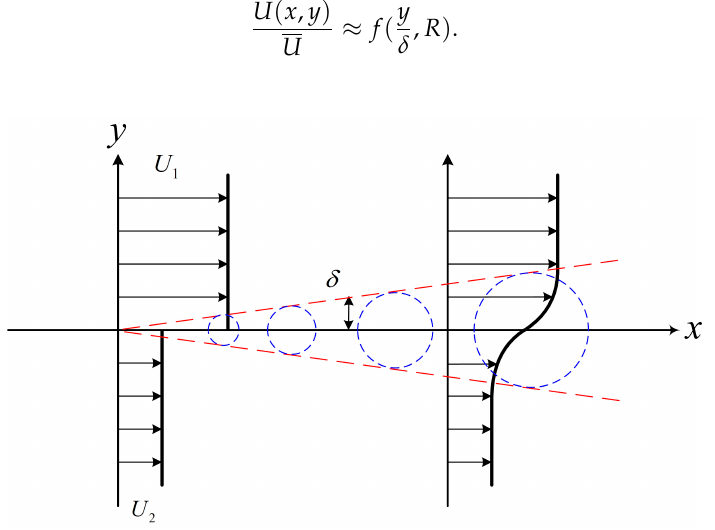
Figure 6. Schematic representation of free shear flow development.